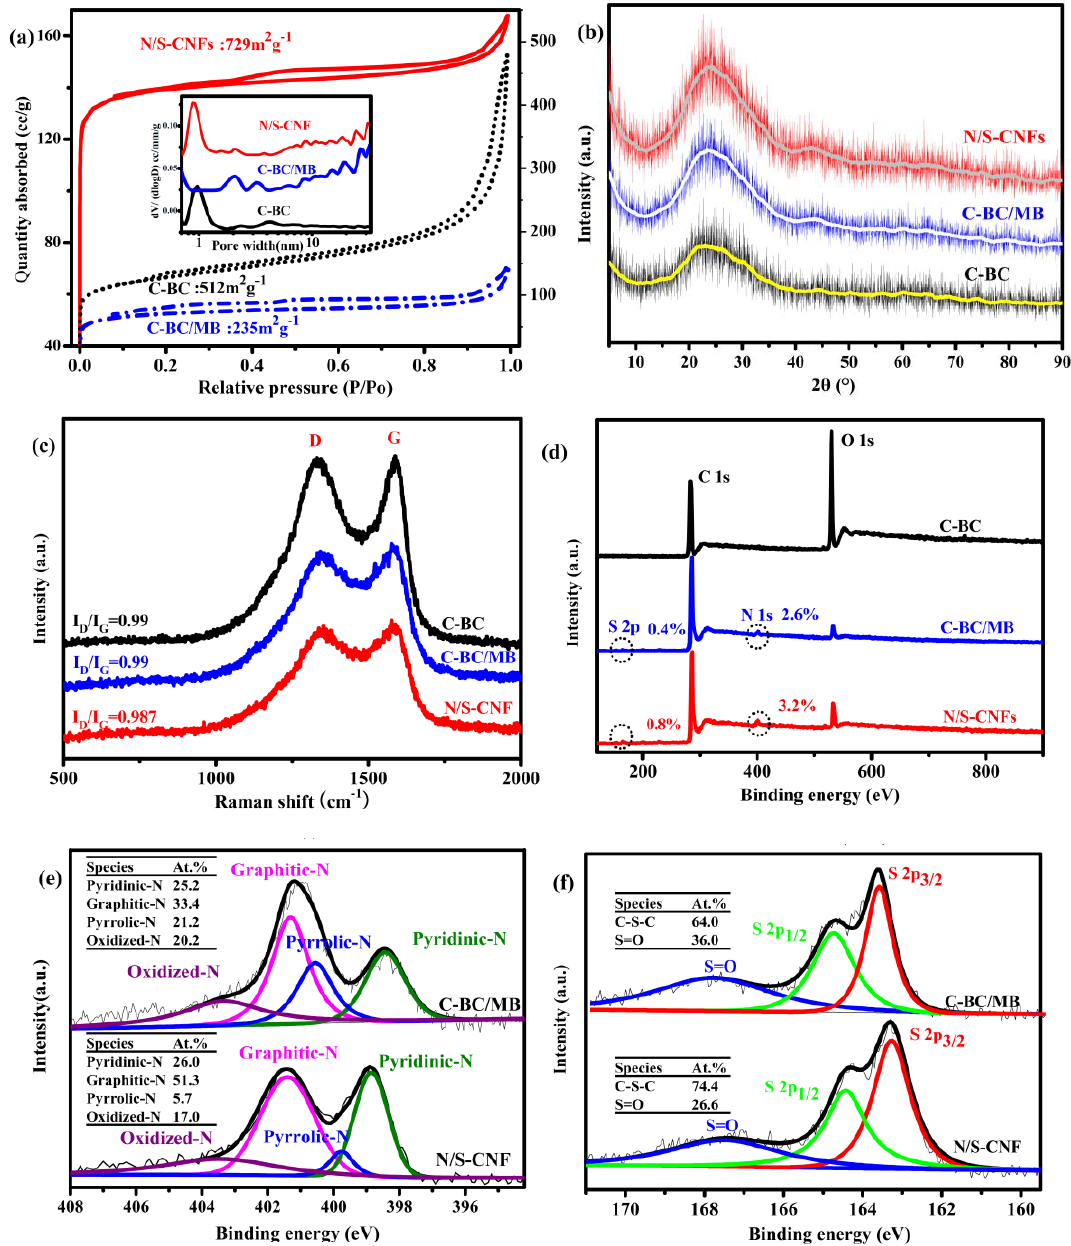
Figure 5. ( a ) N 2 adsorption-desorption isotherms and the inset is the pore size distribution curve, ( b ) XRD patterns, ( c ) Raman spectra and ( d ) XPS full spectra of C-BC, C-BC/MB and N/S-CNF; ( e ) N1s and ( f ) S2p fine XPS spectra of C-BC/MB and N/S-CNF.